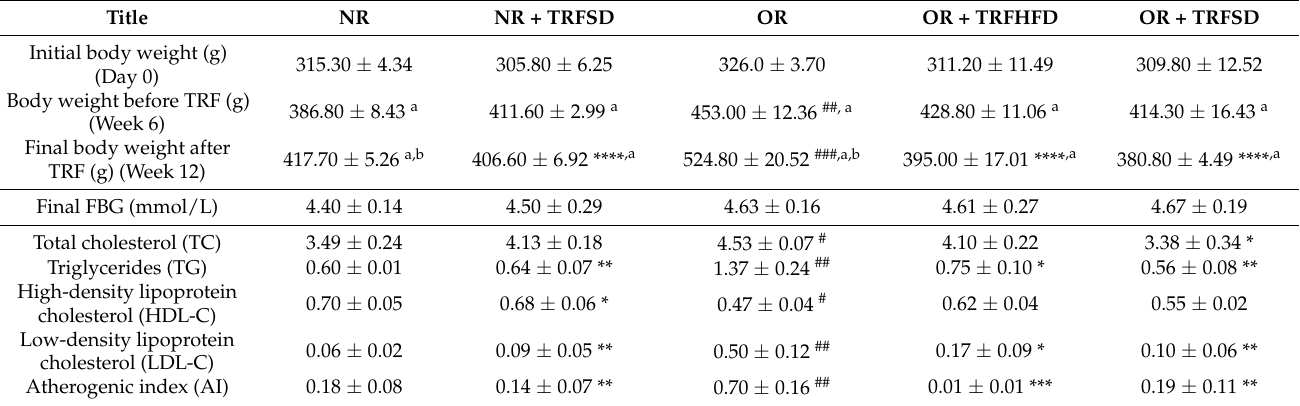
Table 2. Body weight and FBG levels in normal and obese